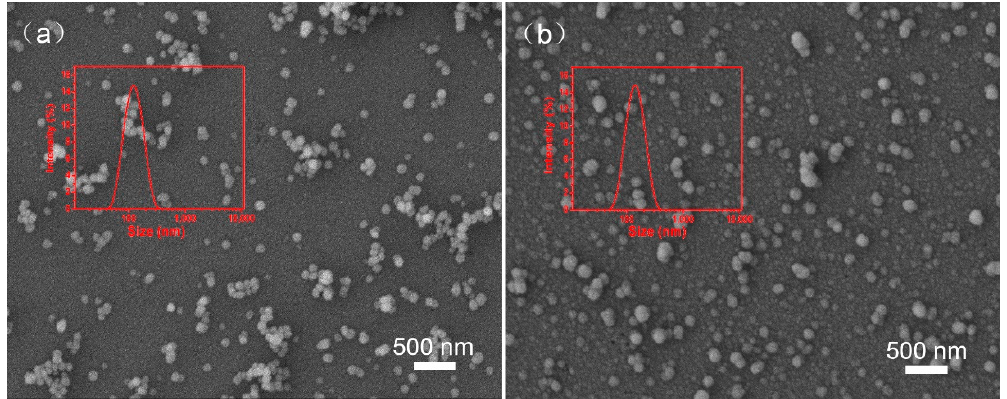
Figure 5. The DLS and SEM image of the BNPs at different storage temperature. ( a ) BNPs at 0 °C for 7 days, ( b ) BNPs at 54 °C for 14 days.